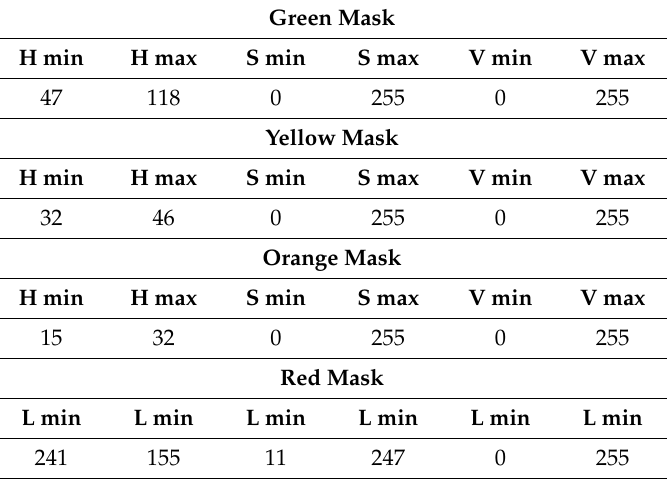
Figure 6. Pre-processing of images: ( i ) binarization of the image captured from the fruit; ( ii ) segmentation of the image and discrimination of areas; ( iii ) obtaining segmented sample applying the green mask of interest region; ( iv ) obtaining segmented sample applying the yellow mask of interest region; ( v ) obtaining segmented sample applying the orange mask of interest region; and ( vi ) obtaining segmented sample applying the red mask of interest region. Table 1. Segmentation mask thresholds.